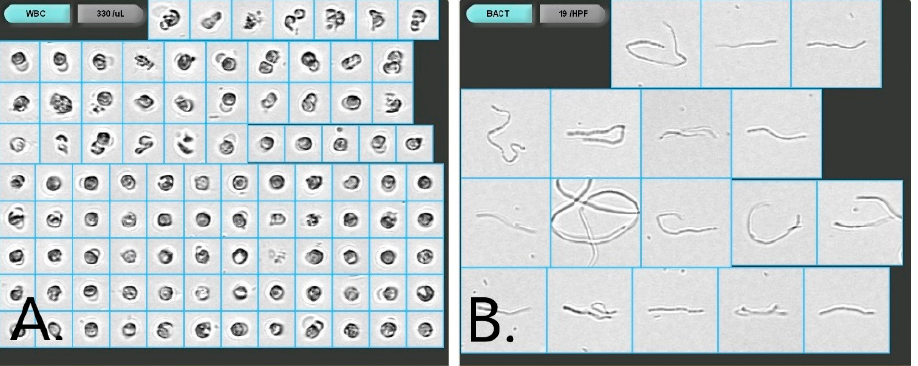
Figure 1. Urine sediment examination ( A ) Urine microscopy presenting WBCs and ( B ) long filamen- tous rods (automated microscopy, iQ200, × 400).